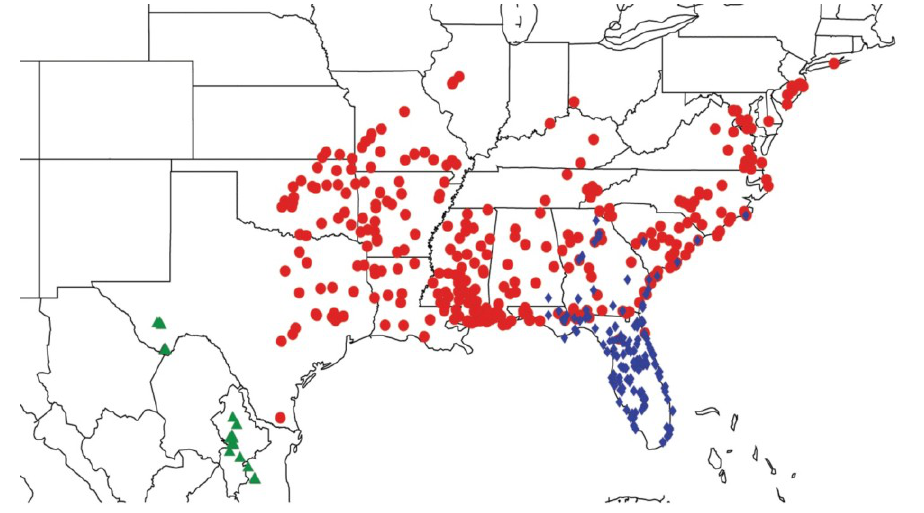
Figure 29. Distribution of Neocicada hieroglyphica hieroglyphica (red circles), N. hieroglyphica johannis (blue diamonds) and N. chisos (green